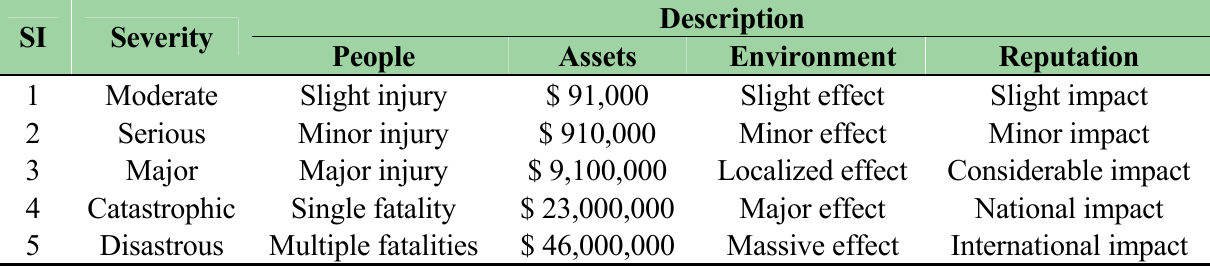
Table 5. Definitions for the severity index table for ships.